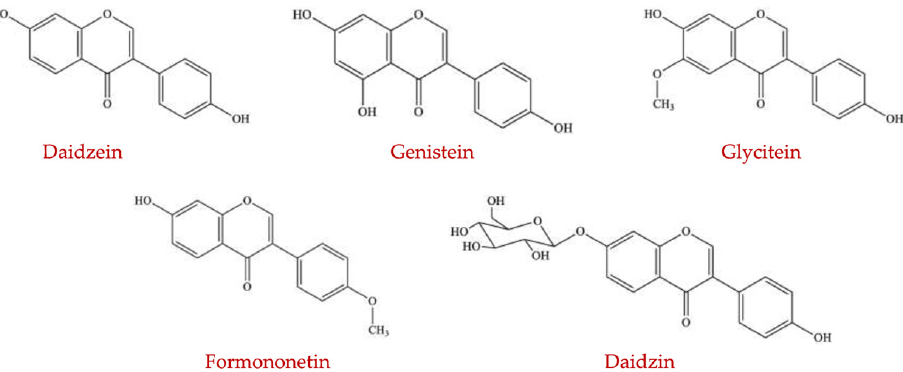
Figure 9. Chemical structures of isoflavones (daidzein, genistein, glycitein, formononetin, and daidzin)